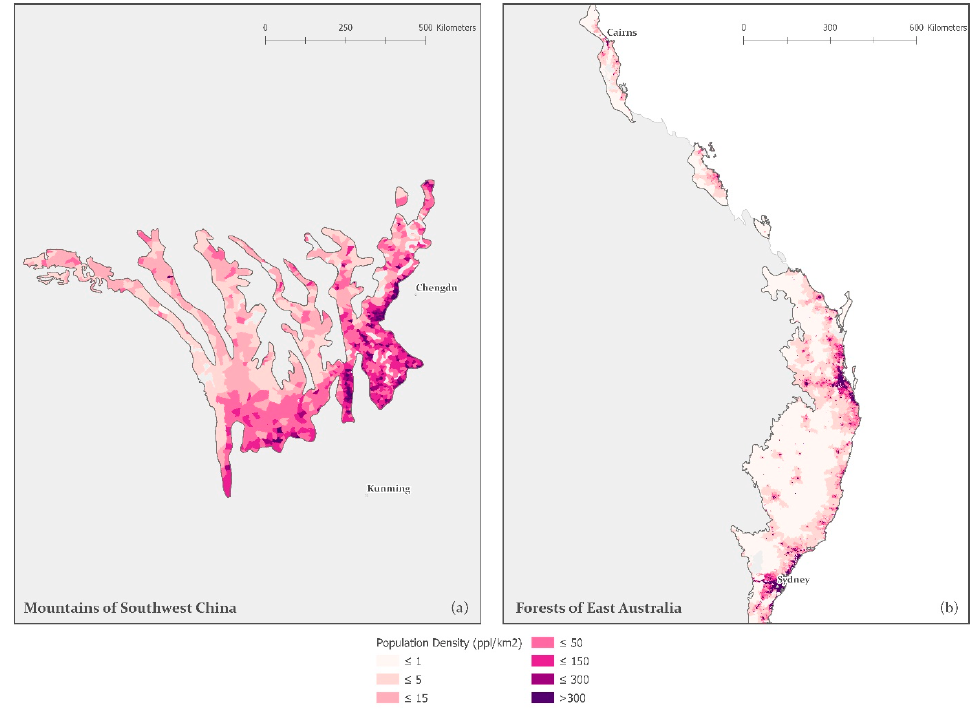
Figure 4. Maps showing the population density of two biodiversity hotspots, the Mountains of Southwest China (11.3% protected area in 2015) ( a ) and the Forests of East Australia (23.1% protected area in 2015) ( b ). Both hotspots have similar average population densities (38 and 41 ppl/km 2 , respectively) and total areas (262,129 and 254,388 km 2 , respectively), but the patterns of population distribution differ.